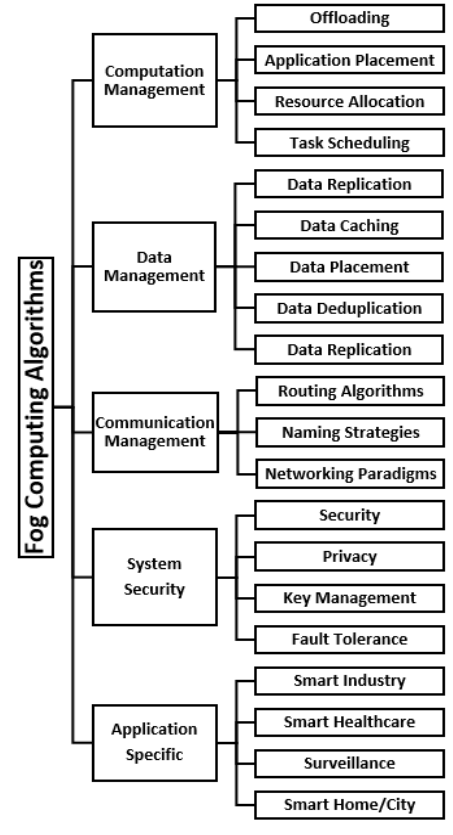
Fig. 2. Classification of Fog